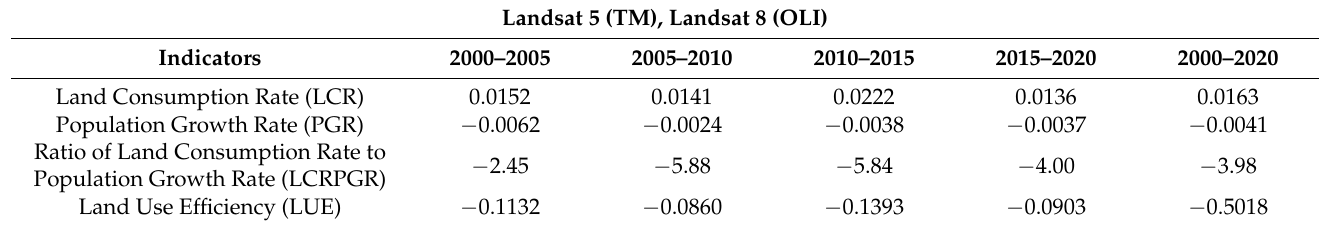
Table 8. Ratio of Land Consumption Rate to Population Growth Rate (LCRPGR) and Land Use Efficiency (LUE) in Opole between